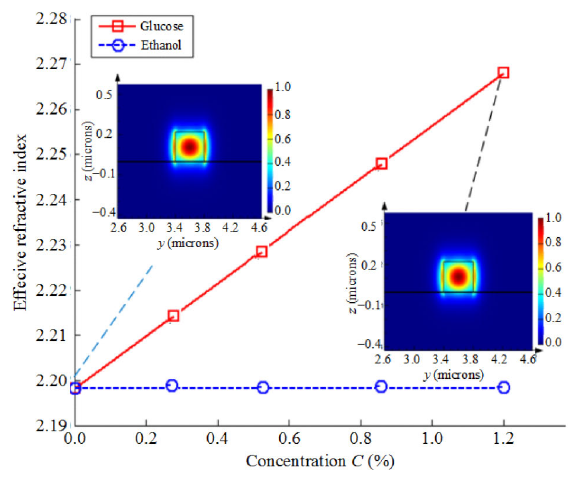
Fig. 5 Effective refractive indexes of the waveguide with glucose and ethanol covers at different concentrations.